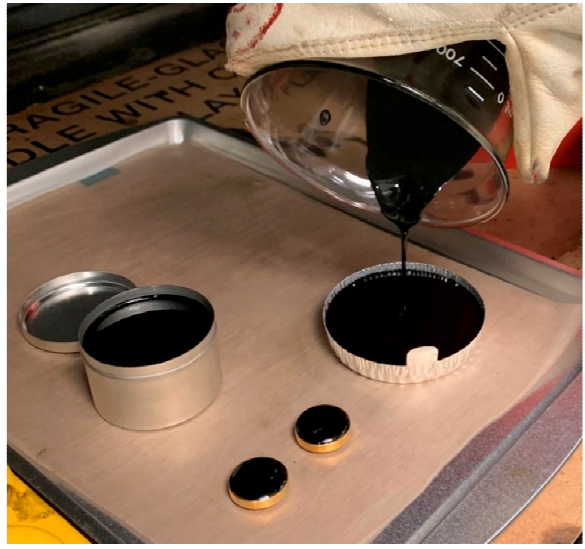
Figure 2. Asphalt in melt form being cast in sample molds for penetration depth and softening point tests.